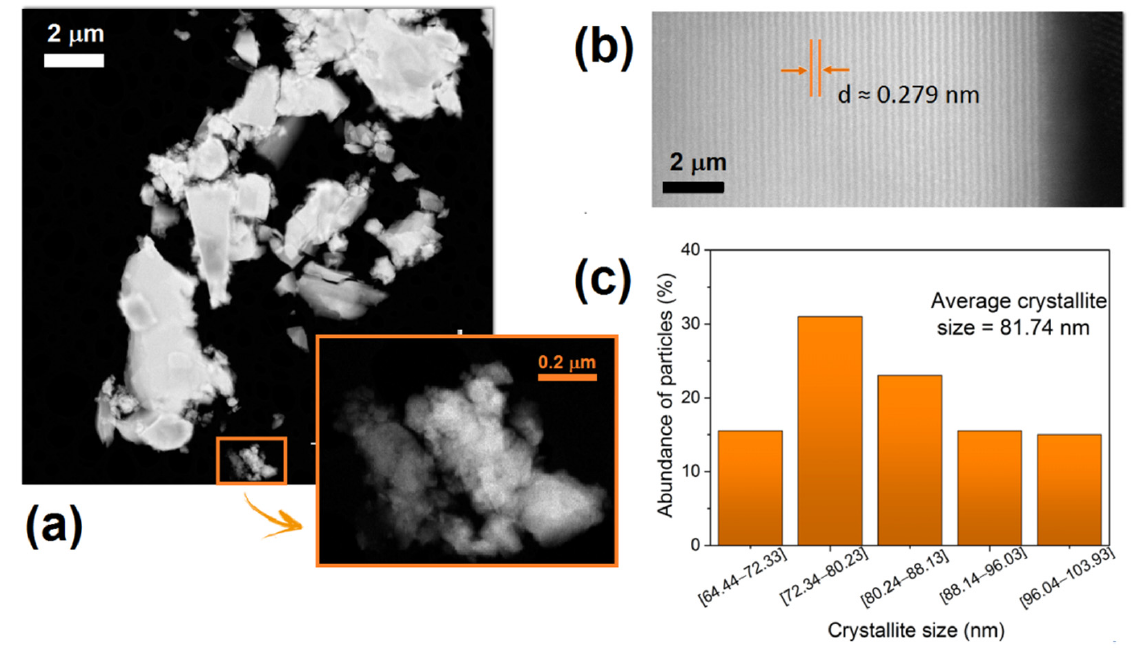
Figure 3. ( a ) STEM micrographs of the HT1600 sample; ( b ) high-resolution STEM micrograph along (040); ( c ) crystallite size distribution and abundance.